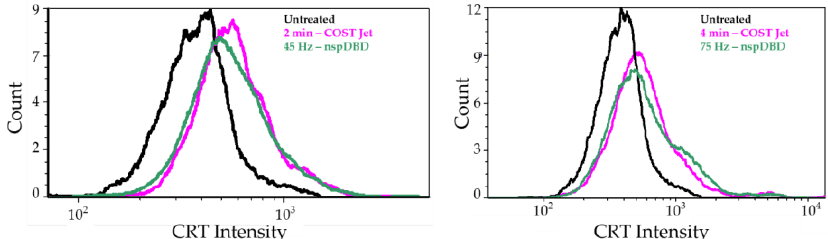
Figure 4. Expression of calreticulin (ecto-CRT) was measured 24 h post-treatment on Jurkat T lymphocytes treated at the two comparable conditions: 2 min / 45 Hz ( Left ) and 4 min / 75 Hz ( Right ). Both devices induced similar increases in the numbers of ecto-CRT-positive